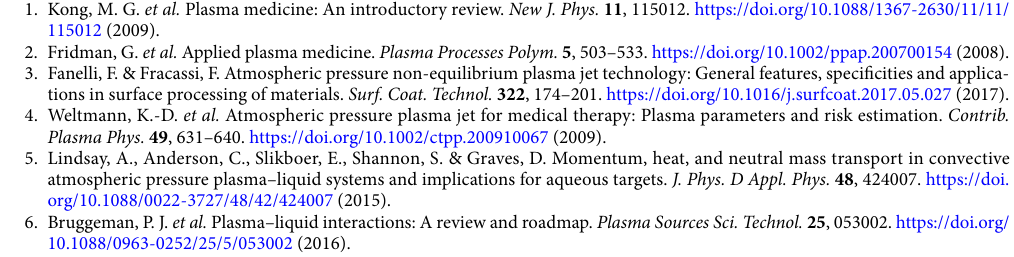
3 0.1 0.1 ) 10 15 cm and 2.8 − ± ± ·